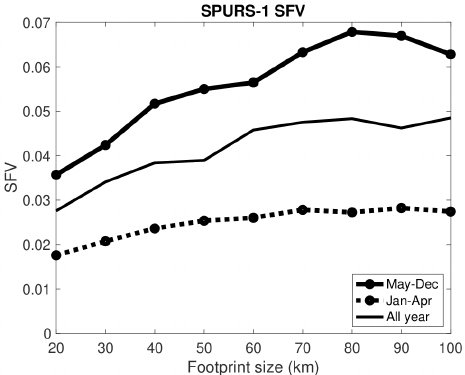
Figure 4. As in Figure 3a. However, the dashed line is for January–April, and the solid line with symbols is for the rest of the year,